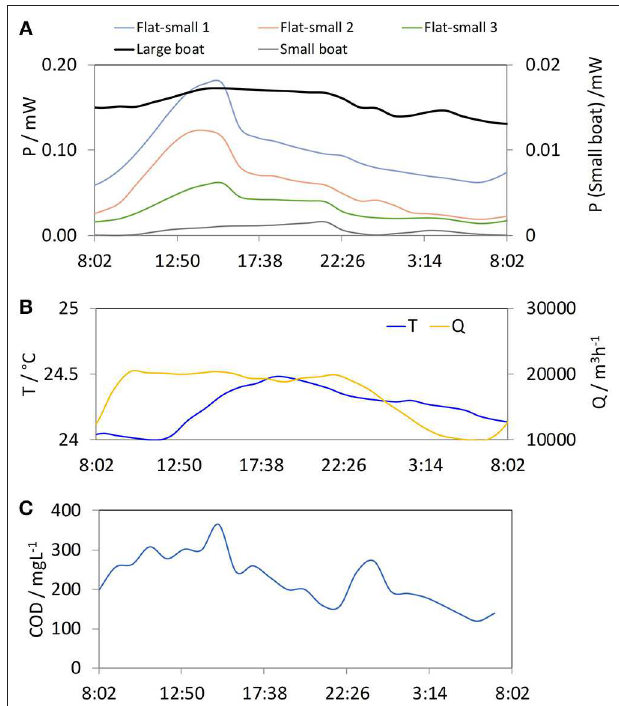
concentration in the wastewater sampled at the inlet of the Milano-Nosedo WWTP is also